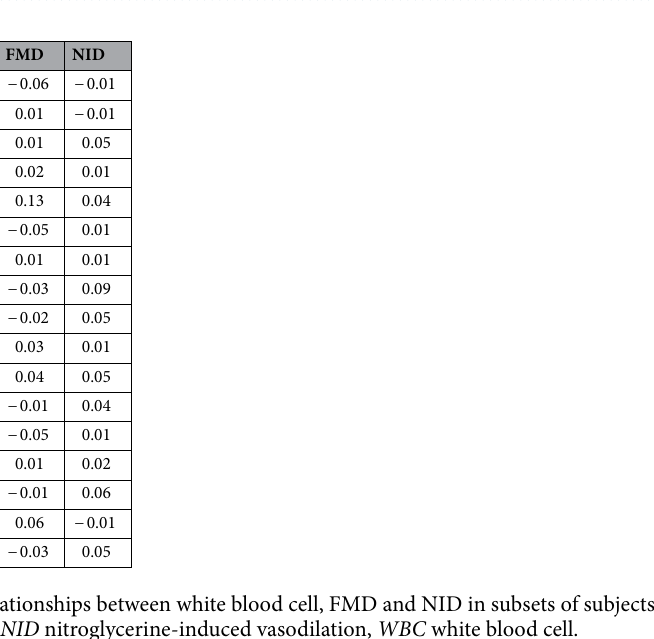
Figure 1. Scatter plots show the relationships between white blood cell count and flow-mediated vasodilation and nitroglycerine-induced vasodilation.